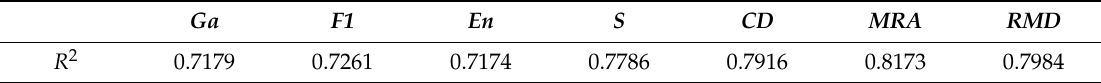
Table 4. Correlation coe ffi cient values of comparative indexes.